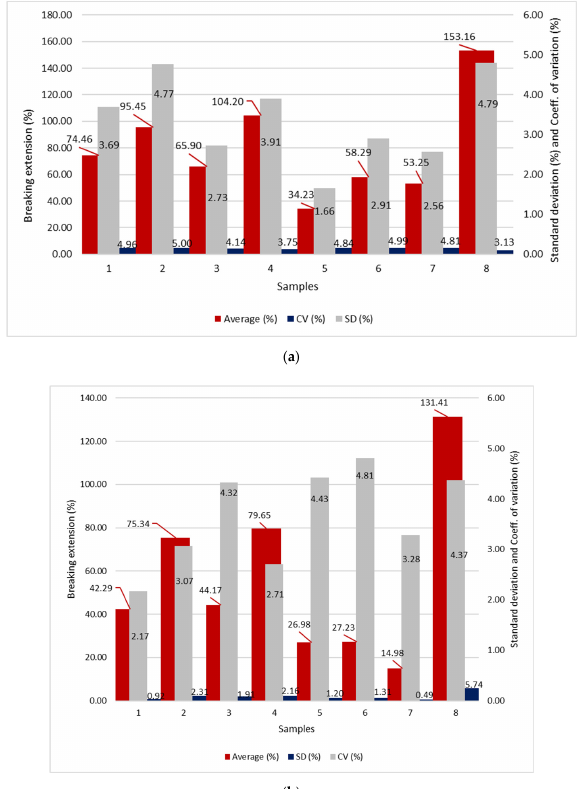
Figure 2. Breaking extension; ( a ) in longitudinal direction and ( b ) in transverse direction; Average breaking extension in %; SD—standard deviation in %; CV—coefficient of variation in %.